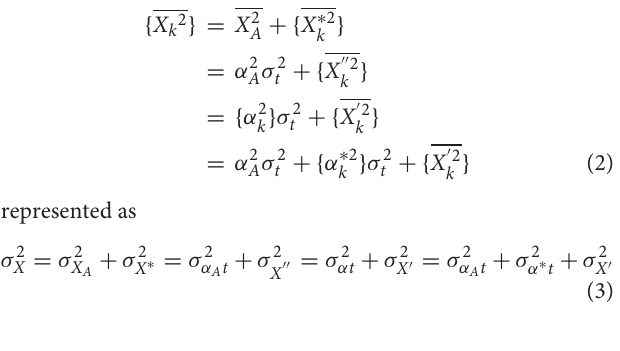
σ 2 X of the ensemble average of the rDn k oE